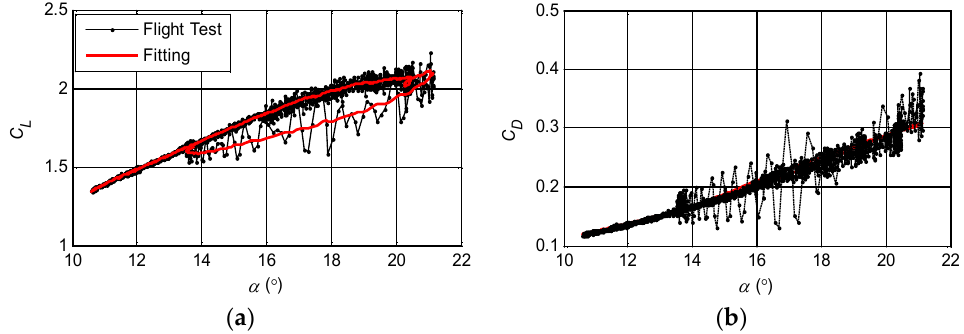
Figure 3. Fitting of the improved stall aerodynamic model to the observation data ( α max = 21.1°). ( a ) C L ~α ; ( b ) C D ~α .